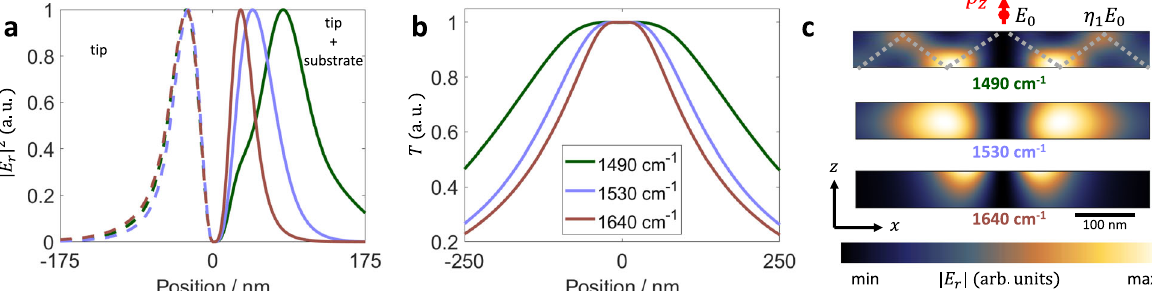
(cid:1) (cid:1) (cid:1) (cid:1) 2 at the graphene layer calculated for a E represent the magnitude of the in-plane fi eld at the zeroth order and 0 1